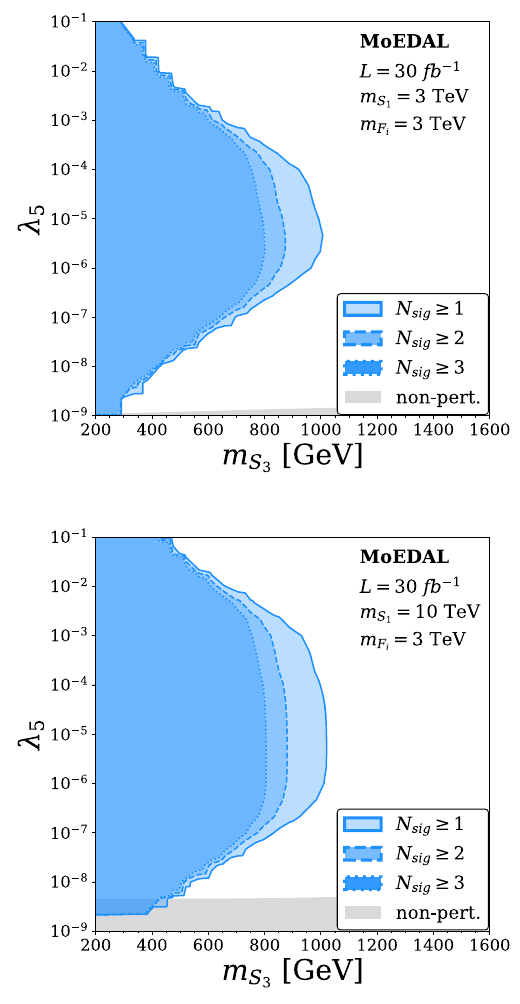
L = 30 and 300 fb − 1 , respectively. We take m F , λ 5 ) 3 = 3 (10) TeV in the top (bottom) panels. The h for all plots and m S 1 and h ¯ are fitted to the neutrino data. In the grey region one of these F couplings tend to be non-perturbative; max ij